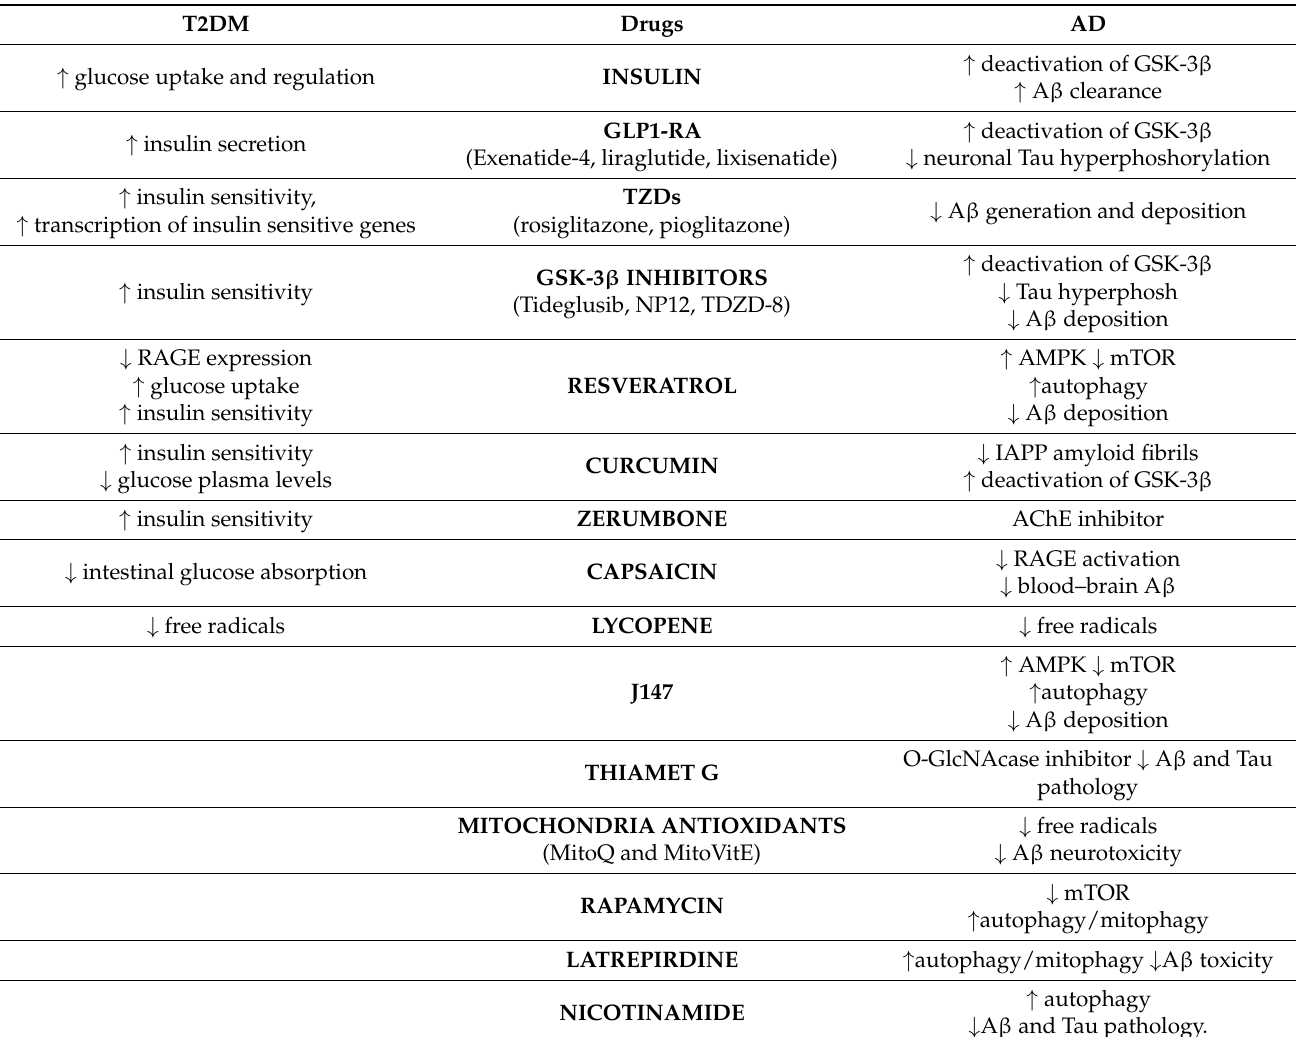
Table 1. Drugs used for treatment of Type 2 Diabetes Mellitus (T2DM) and Alzheimer’s Disease